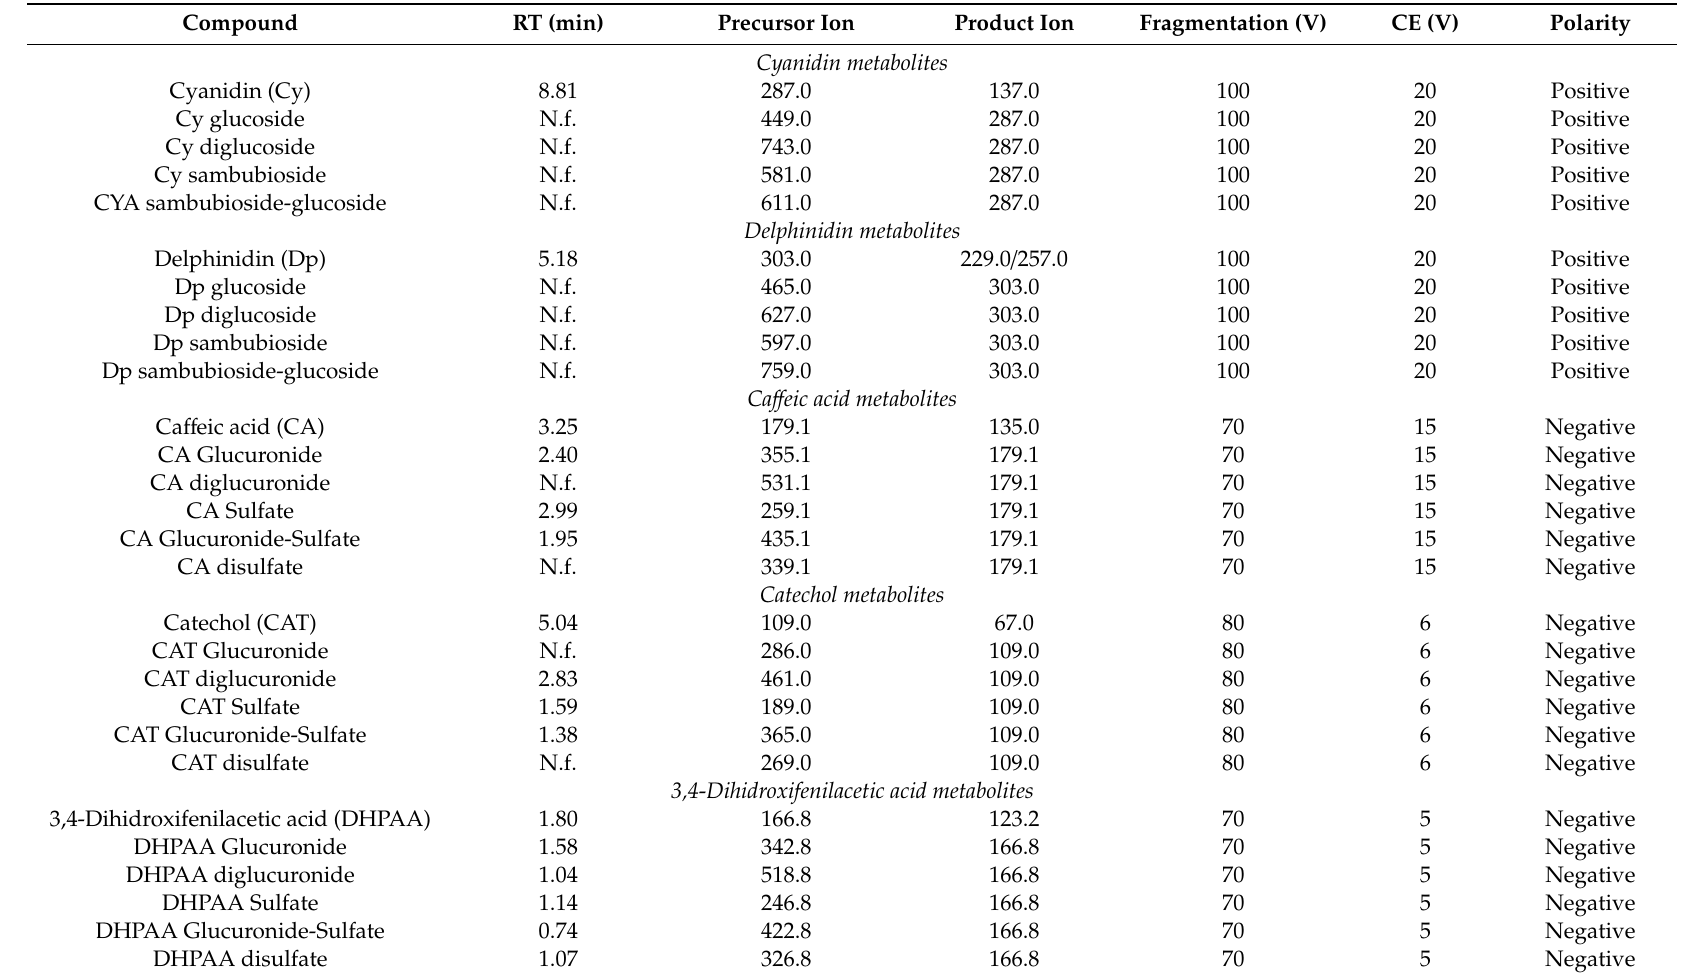
Table 2. Qualitative analysis of phenolic acids and anthocyanin metabolites detected in urine samples in non-hydrolyzed urine after the ingestion of the juices developed in the present